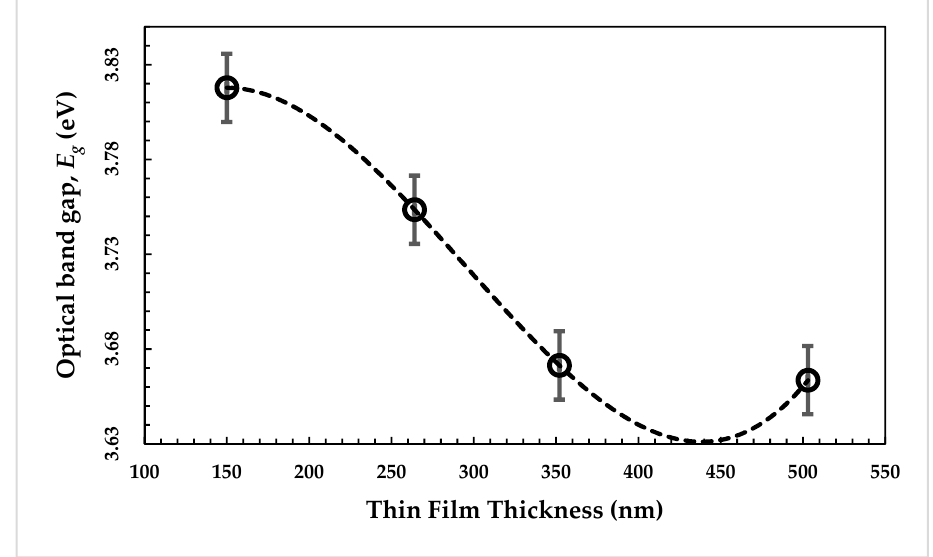
Figure 6. Dependence the optical band gap on the film thickness.